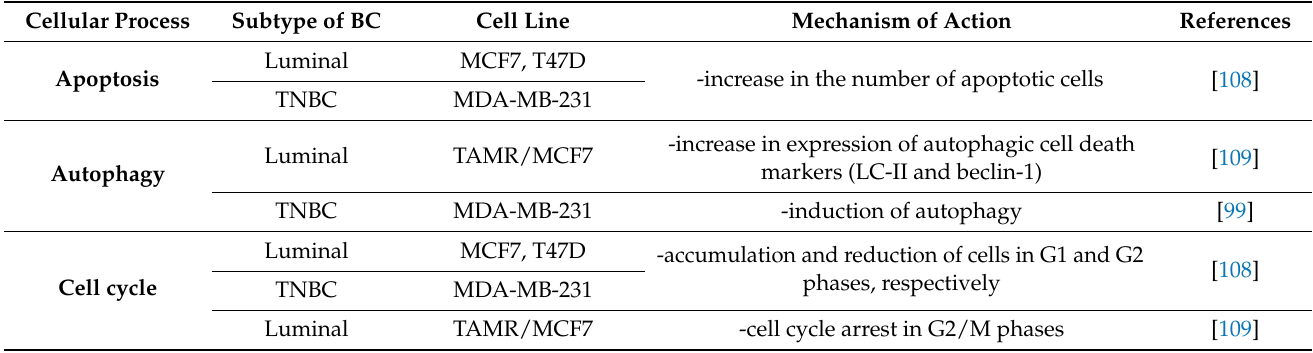
Table 2. Mechanism of action of vorinostat (SAHA) in in vitro and in vivo breast cancer (BC) pre-clinical setting (BC—breast cancer, EMT—epithelial mesenchymal-transition, ER—estrogen receptor, FOXA1—forkhead box A1, LC3-II—microtubule- associated protein 1A/1B light chain 3-II, mutp53—mutated p53, TAMR—tamoxifen resistant, TNBC—triple-negative breast